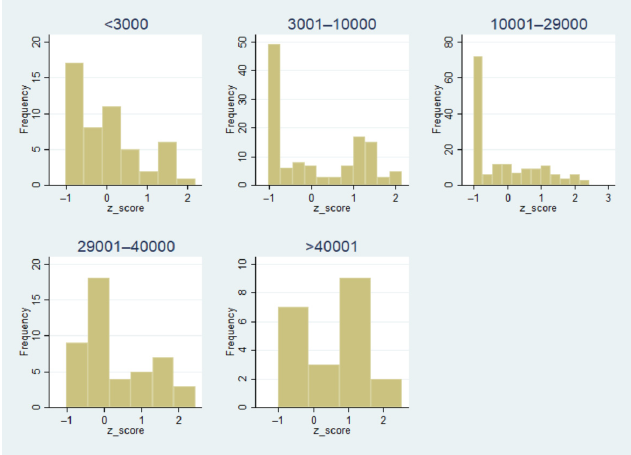
Figure 4. Financial literacy scores by income group.